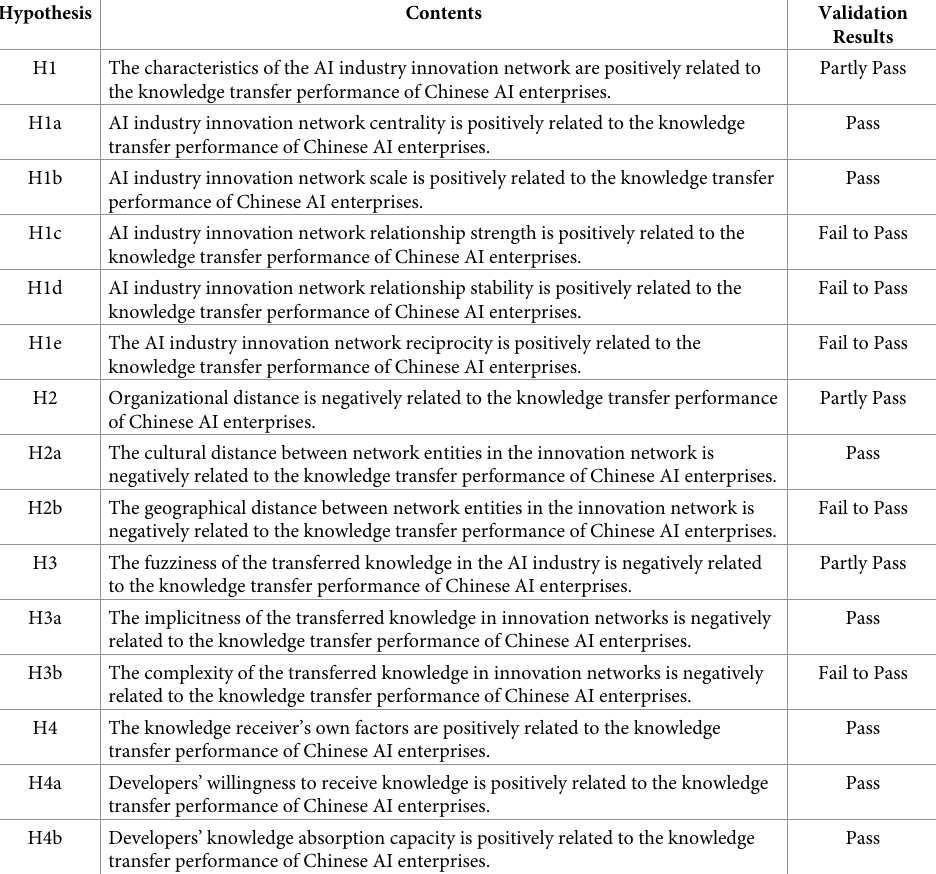
Table 16. Classified regression analysis